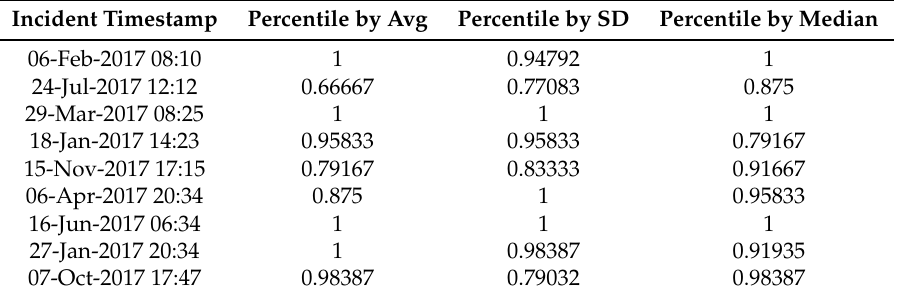
Table 11. Percentiles of Phase 2-Train incidents when sorted by sensor, day of year, and time of day. Incident Timestamp